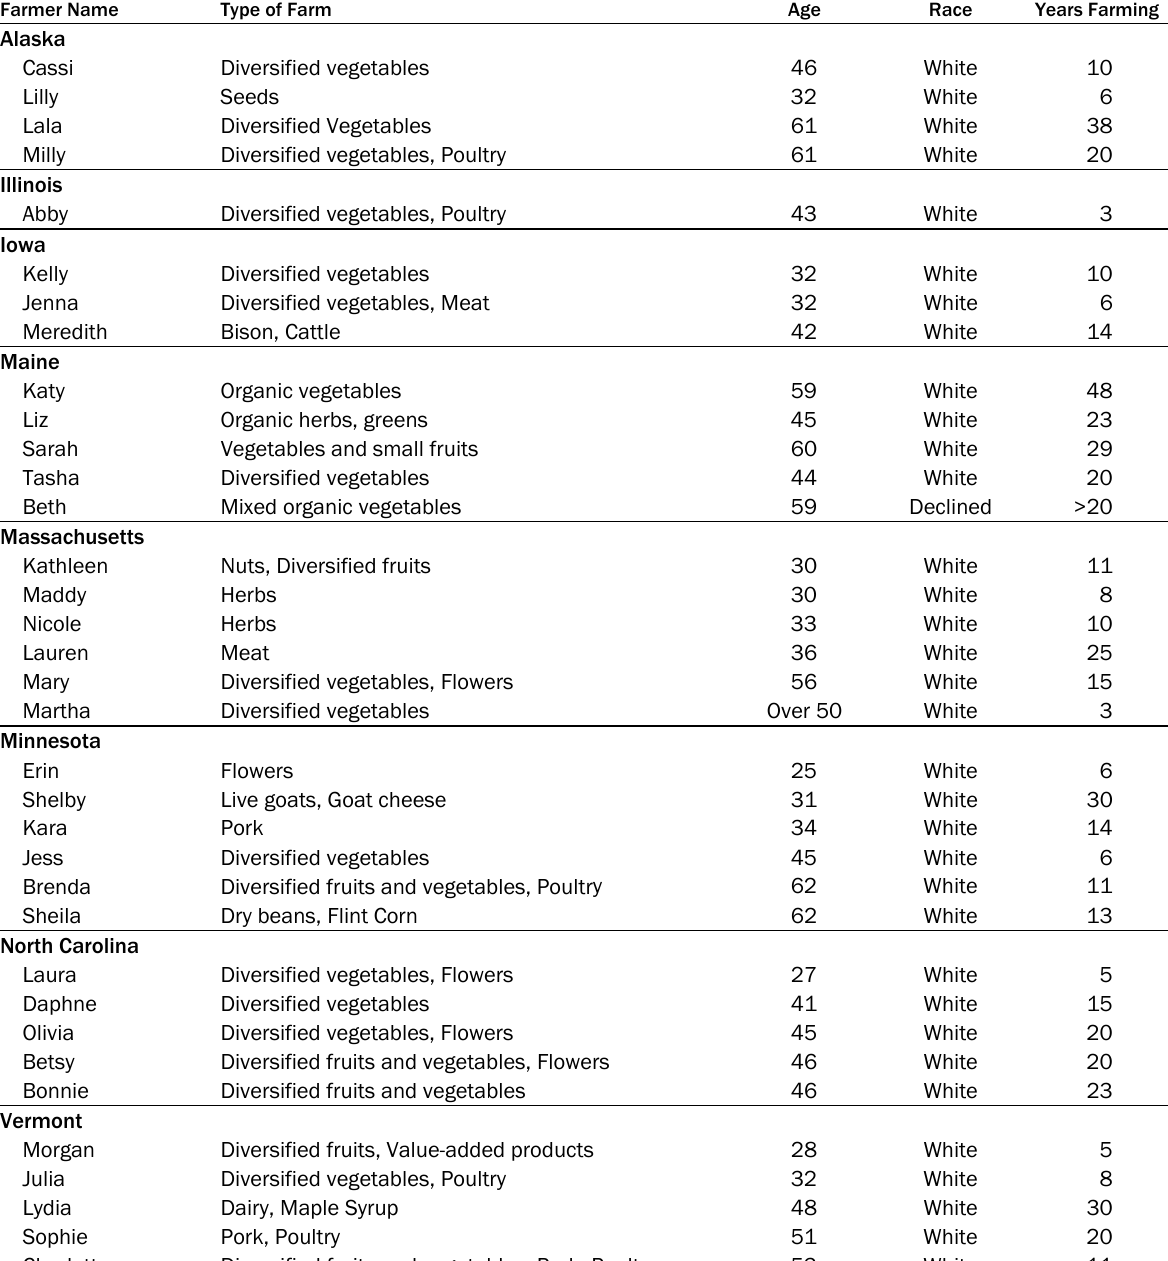
Table 1. Name and Farm Type for all Participant